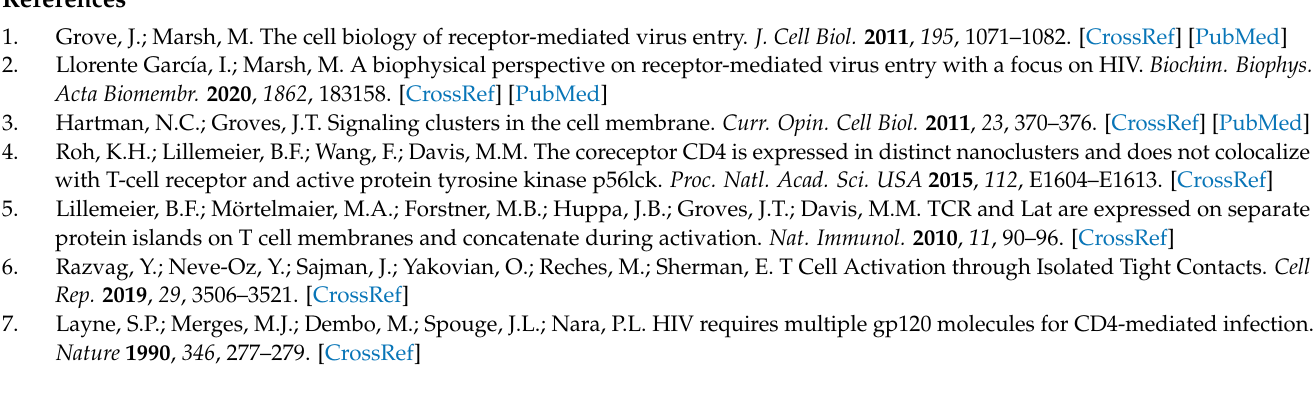
block, Figure S2. Localisation maps for STORM imaging data. Figure S3. Experimentally obtained localisation precision σ for Alexa Fluor 647. Figure S4. Calibration data for molecule counting from STORM data. Figure S5. Comparison of CD4 cluster diameters distributions determined by automated Clus-DoC analysis and manual measurements. Figure S6 . CD4 does not cluster on HIV-1 treated cells at 4 ◦ C. Figure S7. Analysis of CD4 clusters colocalised with HIV. Figure S8 . Diameters and densities of CD4 clusters on HIV-treated and untreated cells. Figure S9. Statistical modelling of CD4 surface